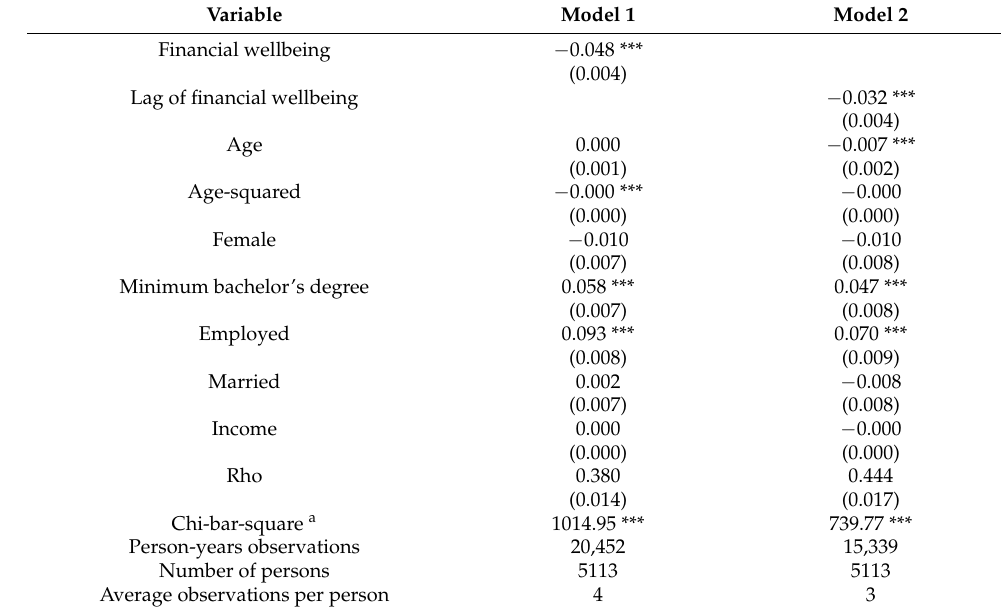
Table 7. Results of the panel binary logistic random-effects regression model.